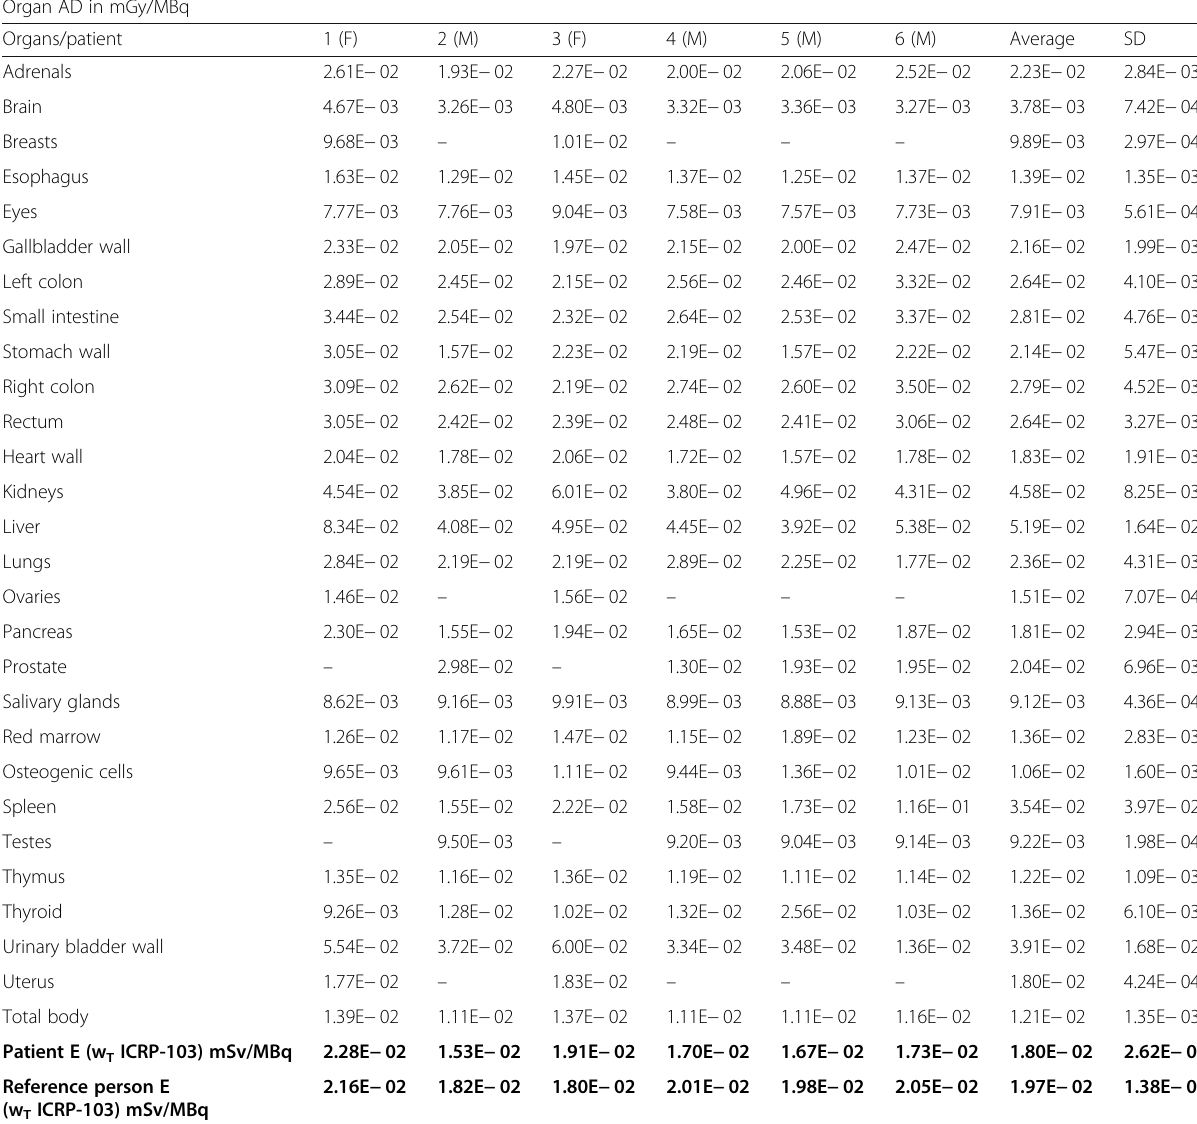
Table 3 Average organ AD and E according to OLINDA/EXM 2.0 for a 1-h urinary voiding cycle. Reference organ masses for the